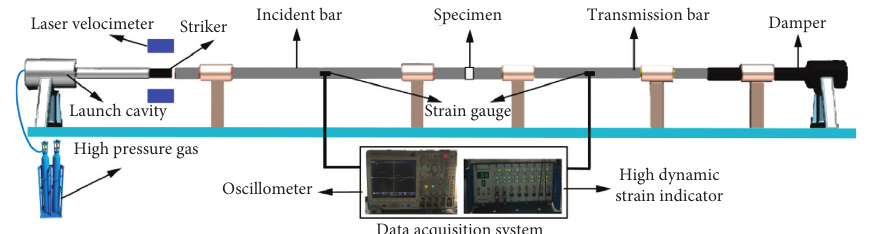
Figure 3: Split Hopkinson pressure bar test